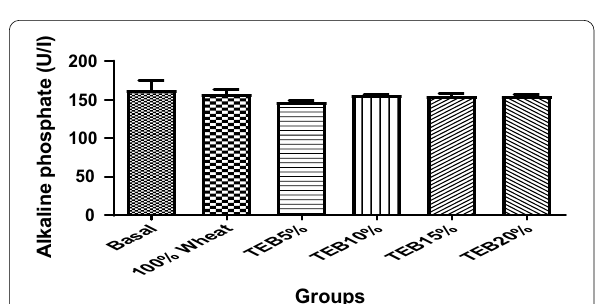
Fig. 9 Effect of enzymatic tacca–wheat biscuit on albino Wistar rats by creatinine. Basal: Rats fed with animal chow. 100% Wheat: Rats fed with 100% wheat flour biscuit, TEB5%: Rats fed with 5% enzymatic 95% + tacca flour 95% wheat flour biscuit, TEB10%: Rats fed with 10% + enzymatic tacca flour 90% wheat flour biscuit, TEB15%: Rats fed + with 15% enzymatic tacca flour 85% wheat flour biscuit, TEB20%: + Rats fed with 20% enzymatic tacca flour 80% wheat flour biscuit +